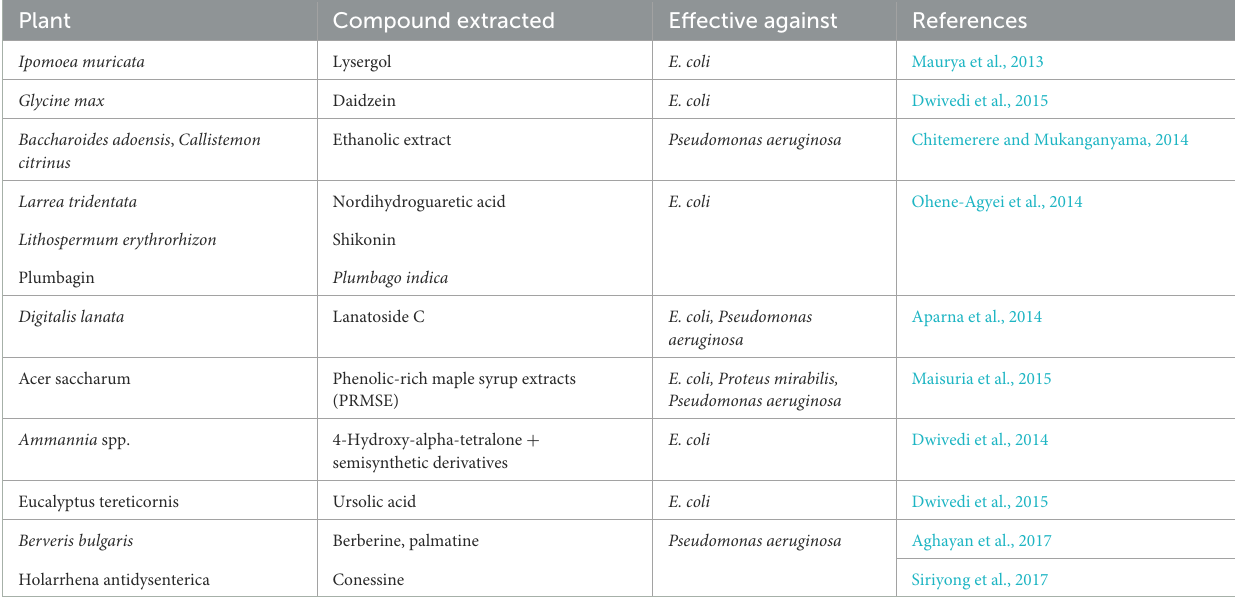
TABLE 2 List of plant-derived efflux pump inhibitors (EPIs) having inhibitory action toward Gram-negative bacteria.